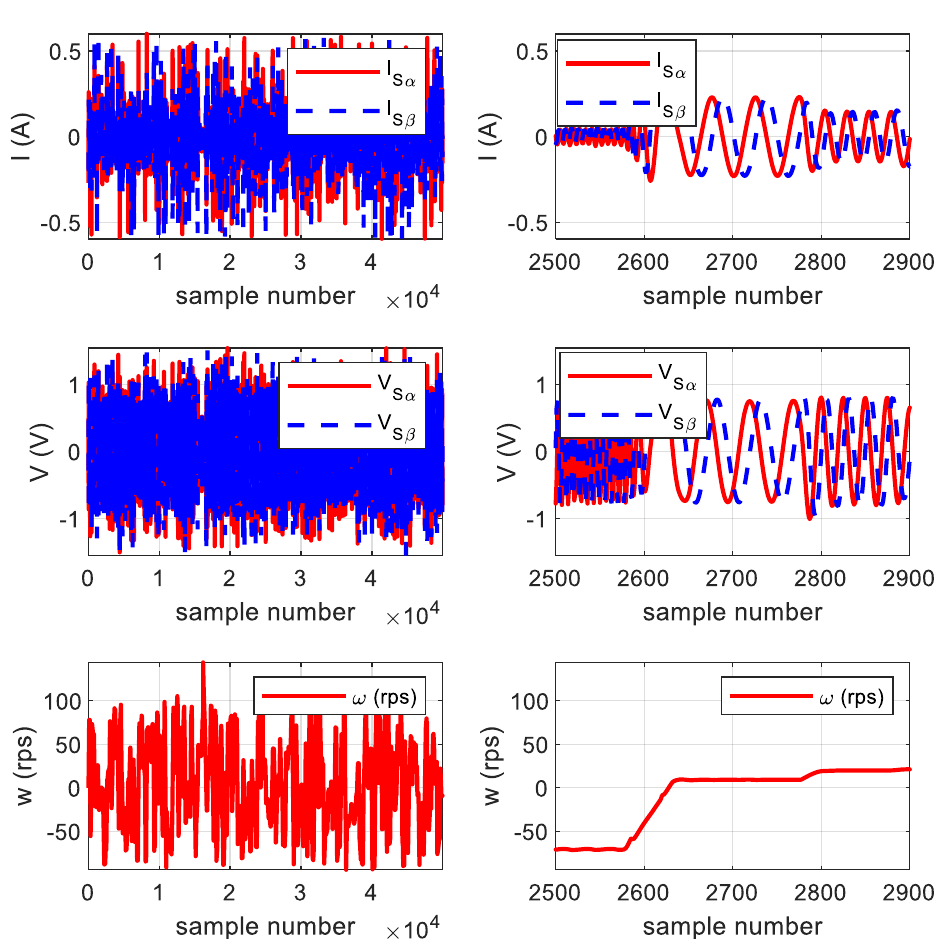
Figure 11. Simulink diagram ANN-based flux estimator.